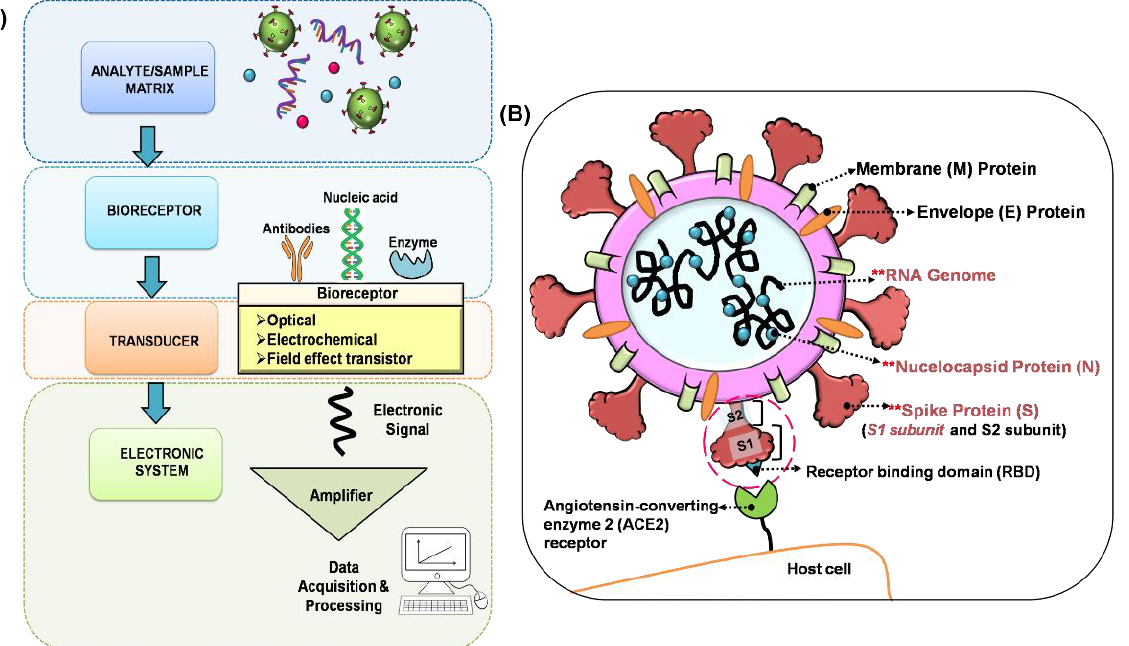
Figure 1. ( A ) Schematic diagram of a biosensor. ( B ) Structure and function of SARS-CoV-2 virus. The main four viral surface proteins are Spike (S), Envelope (E), Membrane (M) and nucleocapsid (N). S protein contains the receptor-binding domain (RBD) that recognises the host cell receptor, i.e., the human angiotensin-converting enzyme 2 (ACE2). E protein contributes to the assembly and morphogenesis of virions. M protein, which is embedded in a lipid bilayer, is responsible for the release of nutrients at the transmembrane and form the viral envelope. N protein binds to the RNA genome to form the nucleocapsid. **Preferred target analyte used for current COVID-19 biosensor development.